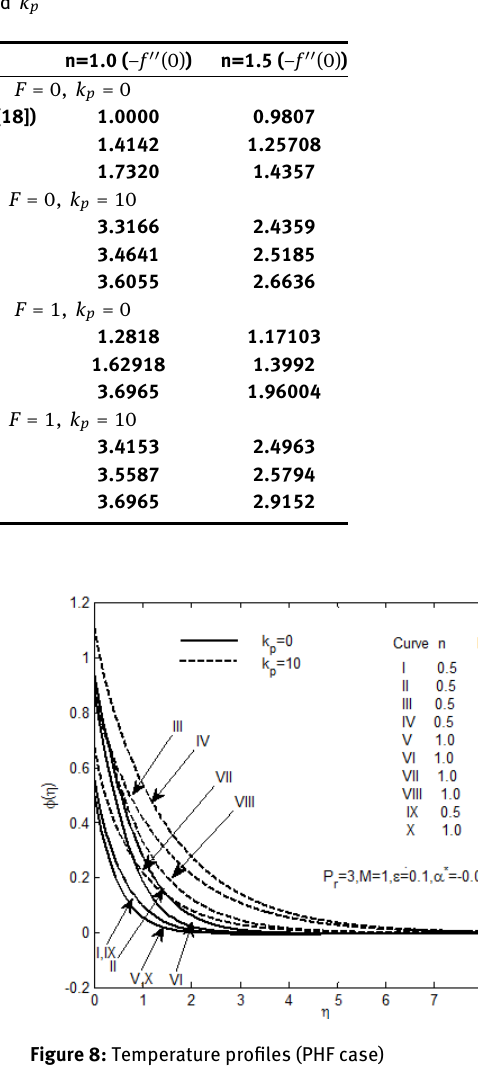
ity is also a resistive force and as described earlier k p aug- mented with high value of magnetic parameter retards the velocity profiles significantly. Figs. 6 and 7 exhibit the variation of temperature for various values of Eckert number E c when P r = 3, M = 1, ε = 0.1, α * = −0.05 = β * , λ = 1. It is evident that E c contributes to enhance the thermal boundary-layer